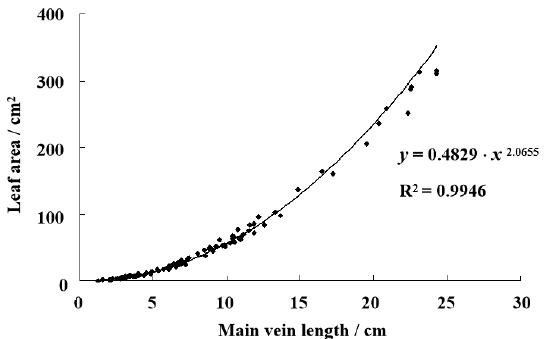
Figure 3. Relationship between the main vein length and the leaf area.